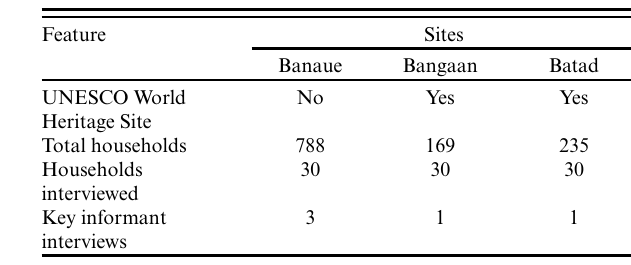
Table 2 . Breakdown of interview participants and key informant interviews by study